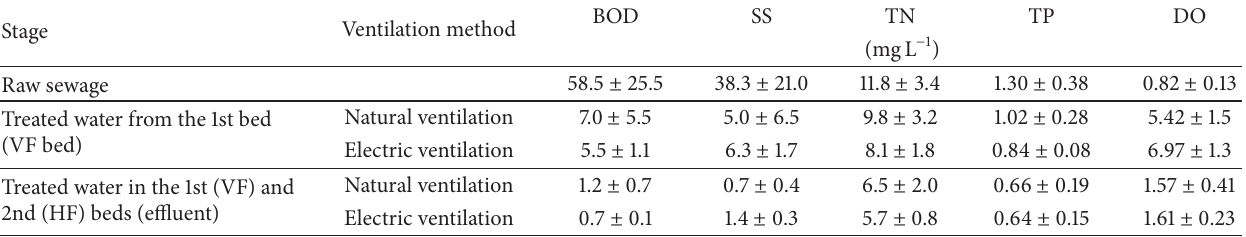
Table 1: Chemical characteristics of raw sewage and treated water in 1st and 2nd treatments.